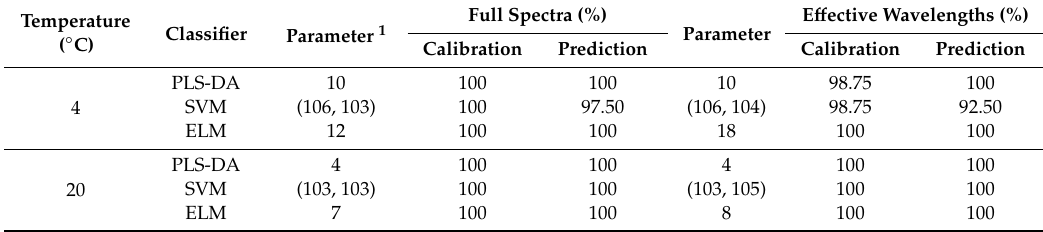
Table 3. Results of classification models using NIR spectra based on full spectra and e ff ective